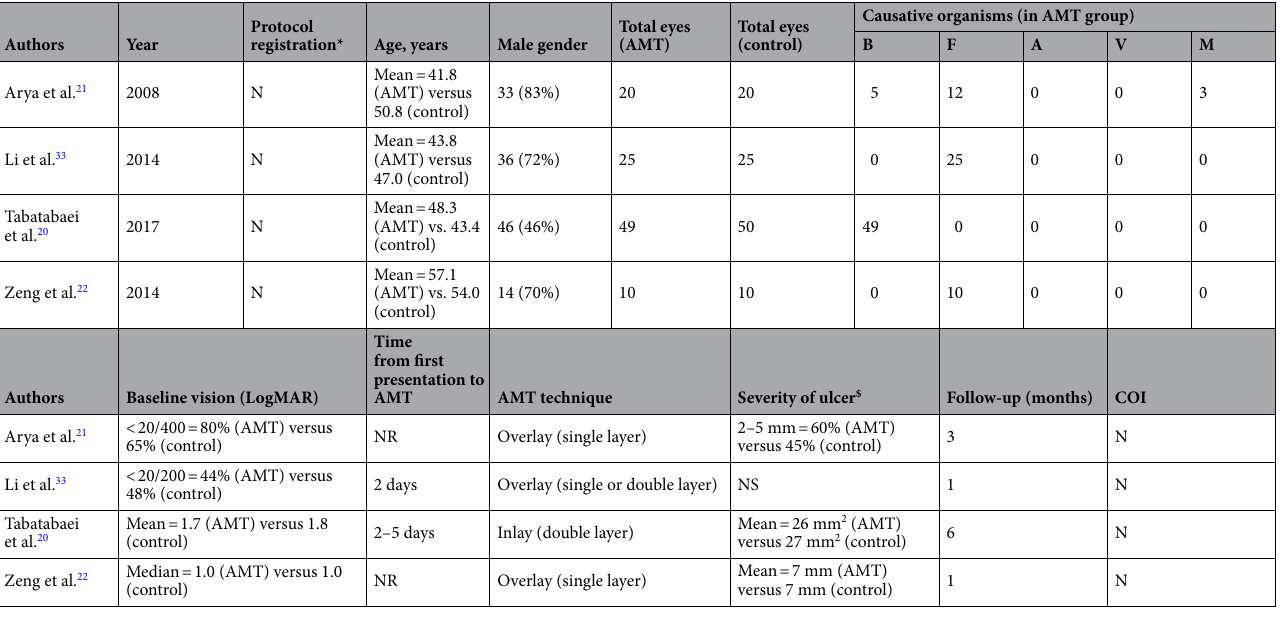
Table 1. Summary of all randomized control trials evaluating the effectiveness and safety of adjuvant amniotic membrane transplantation (AMT) for infectious keratitis. B bacteria; F fungi, A acanthamoeba, V viruses, M mixed infection, COI conflict of interest, NR Not reported. *Prospective registration of the clinical trial protocol in a publicly accessible database. $ Severity of the corneal ulcer is presented either in maximum linear diameter (mm) or in area (mm 2